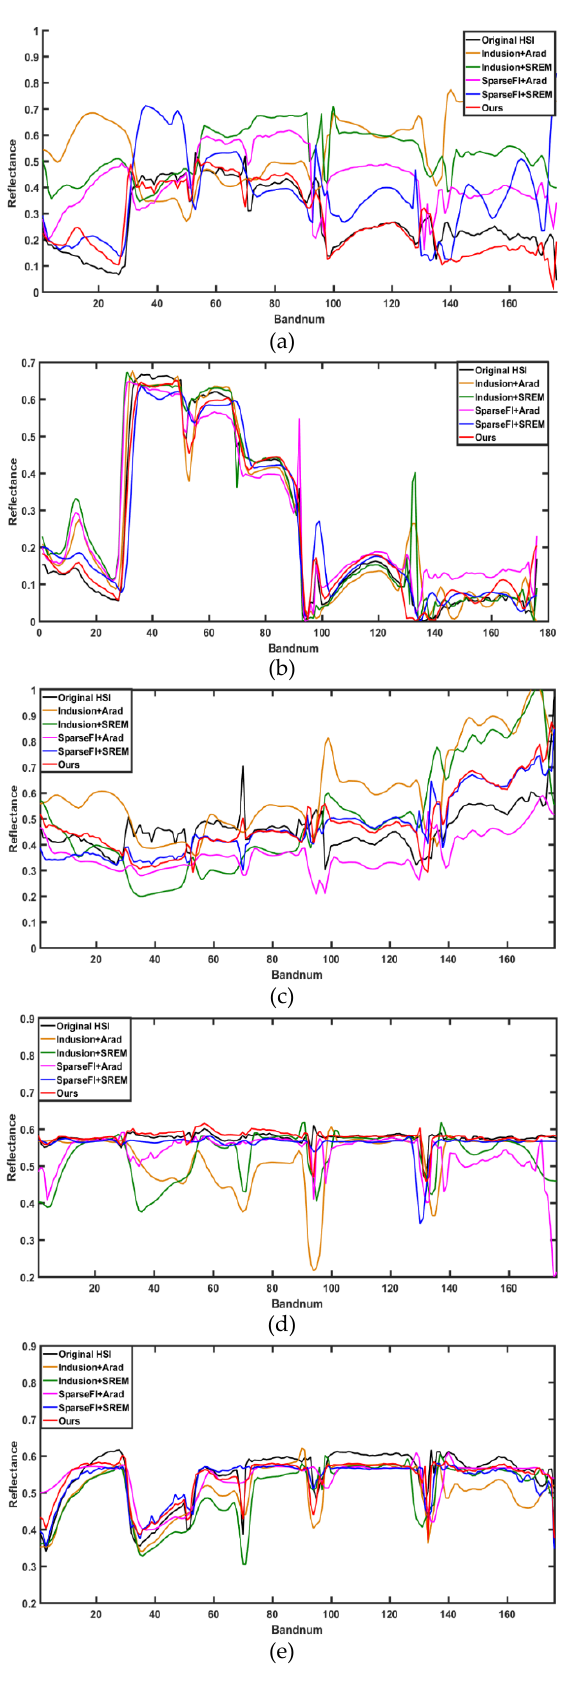
Figure 13. Comparison of reflectance of five selected endmembers in real dataset, ( a ) Wood, ( b ) Lawn, ( c ) Residence, ( d ) Sand land, and ( e ) Crop land.